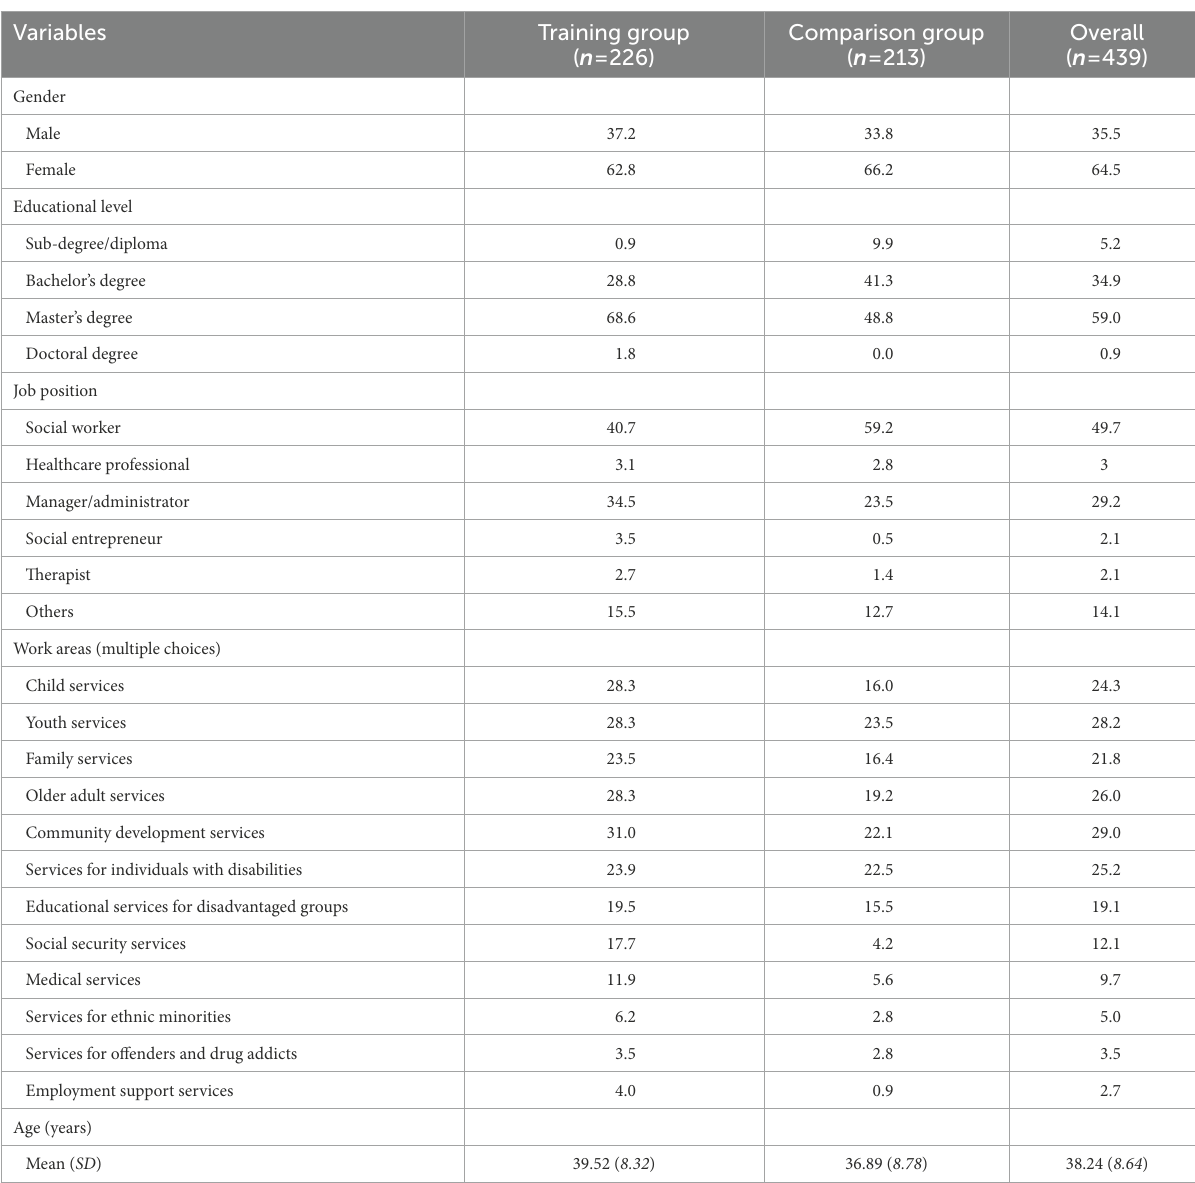
TABLE 1 Profile of participants in the